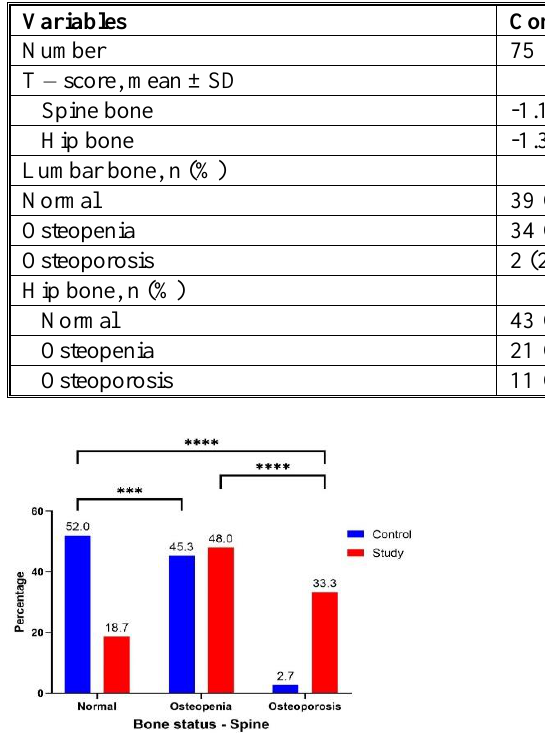
Table 2. Assessment of bone status.